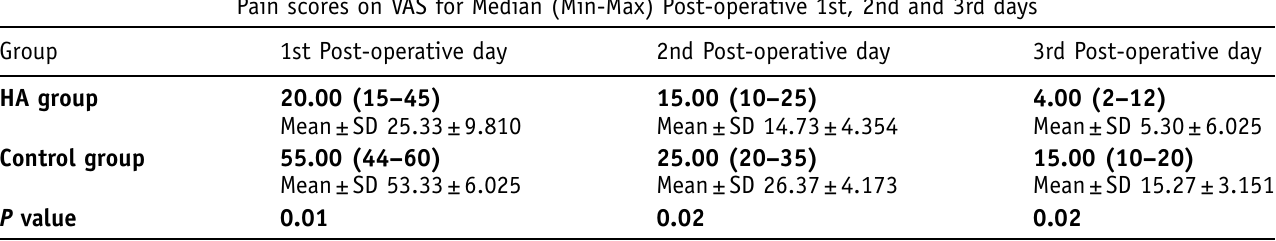
Table IV. Evaluation of pain by VAS score with 30 the patients.